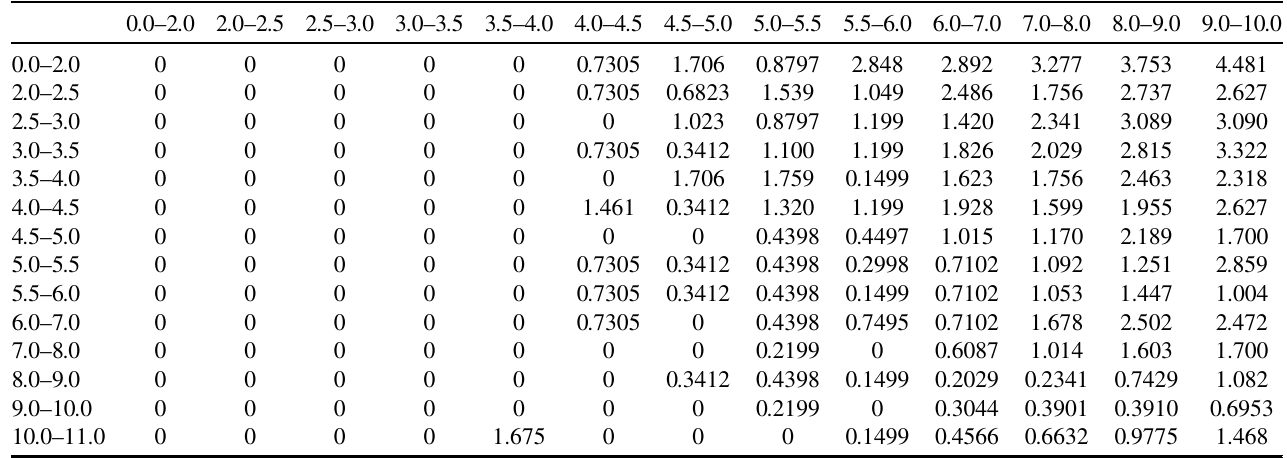
TABLE V. (cid:4) þ background from (cid:3) (cid:5) CC events (all values (cid:2) 10 (cid:1) 4 ).